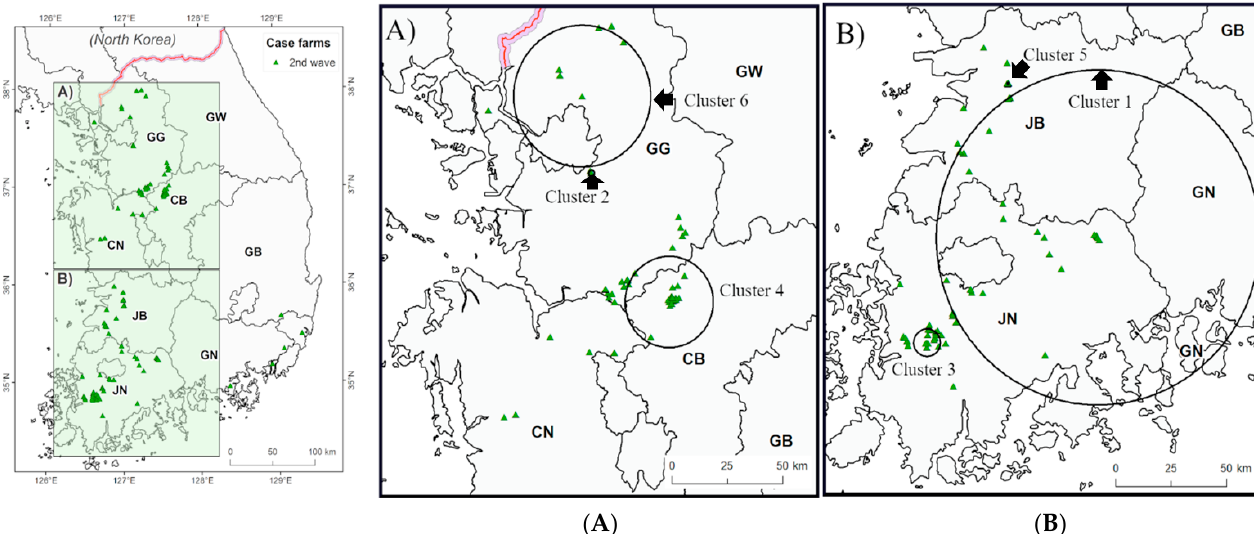
Figure 5. Spatiotemporal cluster of poultry farms during the second wave of HPAI H5N8 outbreaks in Korea. The left map shows whole area of South Korea; ( A ) spatiotemporal cluster of the second wave of HPAI H5N8 in the midwest region; ( B ) spatiotemporal cluster of the second wave of HPAI H5N8 in the southwest region. Green triangles are the outbreaks in poultry farms at the second wave from 23 September 2014 to 24 June 2015. The locations of the clusters are indicated by black circles and clusters name is shown by black arrow. Province abbreviations: CB: Chungbuk, CN: Chungnam, GB: Gyeongbuk, GG: Gyeonggi, GN: Gyeongnam, GW: Gangwon, JB: Jeonbuk, JN: Table 2. Spatiotemporal cluster of Korea poultry farms during HPAI H5N8 outbreaks from 2014 to 2016. Radius Wave Cluster (km)